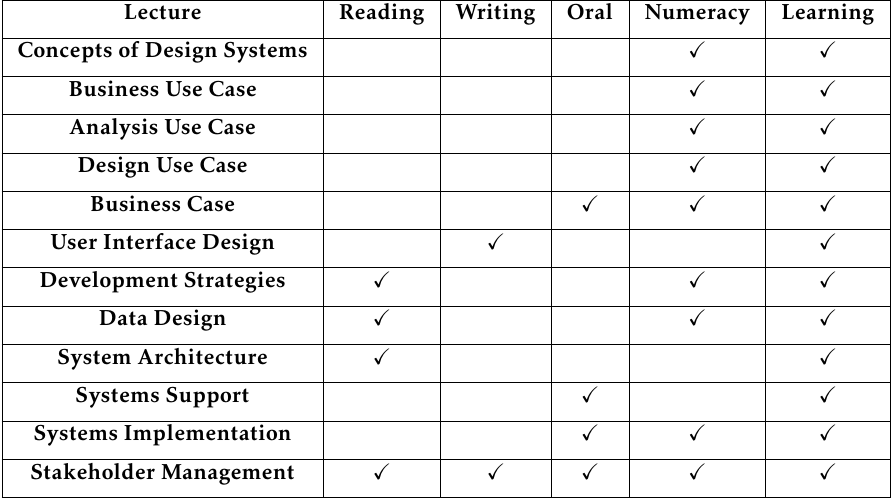
Table 3. Mapping of the key Lectures with Core Skills [13]